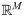
Block diagram of Eq 29, showing how a workflow is created for each node.The first step is one-hot encoding the data to embed it into RM. The next step computes the Mapper graph of the data. Then models are trained on each node, and summed. Finally, a decision function outputs the final class prediction.